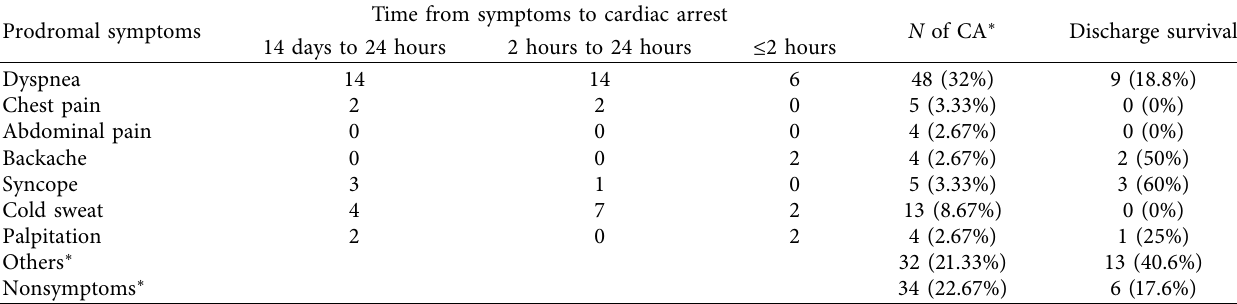
Table 4: Te interval from prodromal symptoms to